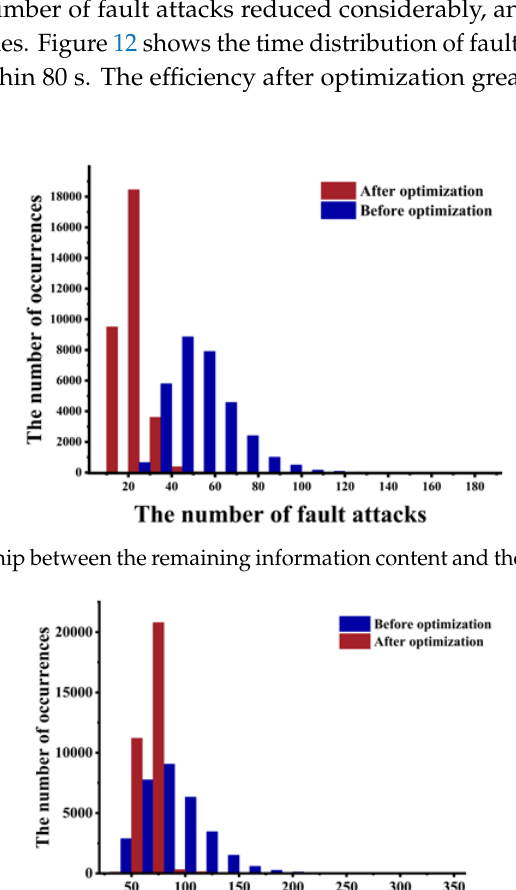
Figure 10. The number of attacks of each column.